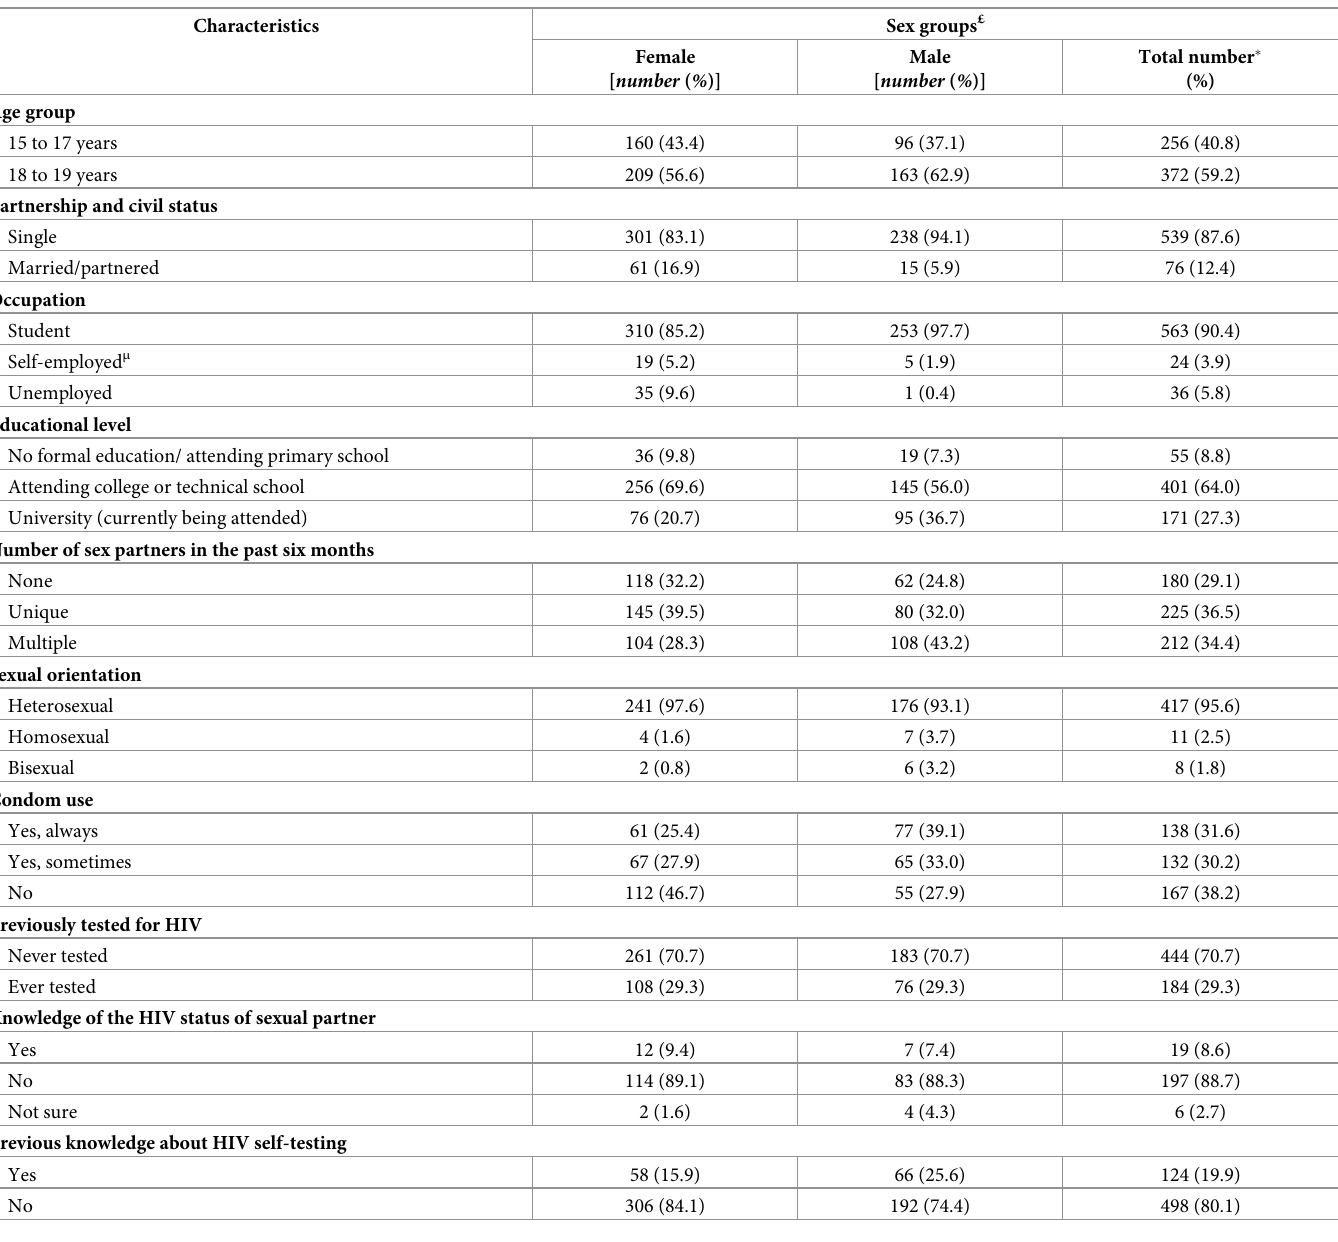
Table 1. Characteristics of 628 adolescents living in Kisangani according to